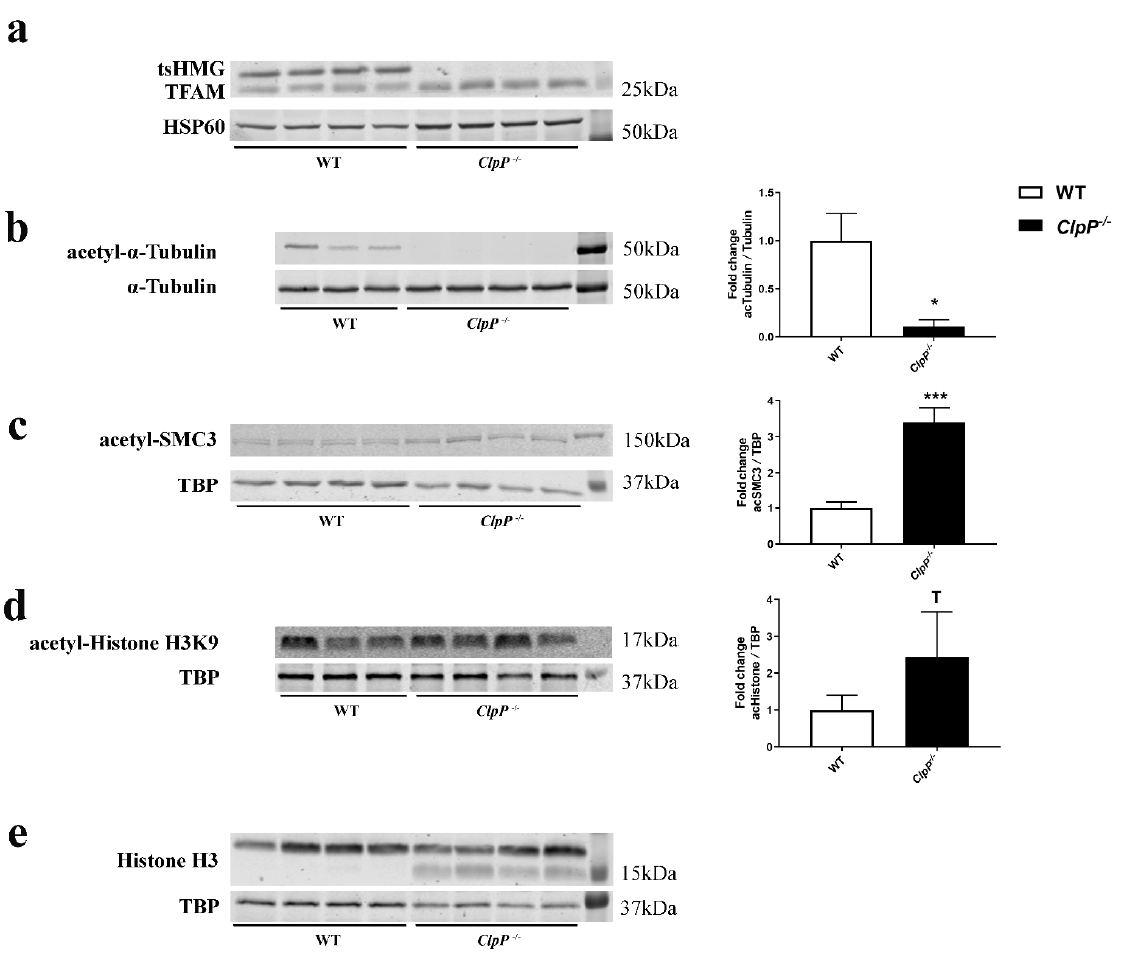
Figure 4. Quantitative immunoblots of whole protein from testis tissues. RIPA fractions from 5-month-old WT and matched CLPP-null testis were analyzed for ( a ) TFAM with its testis-specific isoform (tsHMG), normalized against mitochondrial HSP60, ( b ) acetyl- α -Tubulin, normalized against α -Tubulin, ( c ) acetyl-SMC3, ( d ) acetyl-histone H3K9, or ( e ) Histone H3. In ( a , e ), quantification was not performed, since zero signal would provide unrealistic effect sizes. * p < 0.05, *** p < 0.001, T represents 0.05 < p < 0.10.